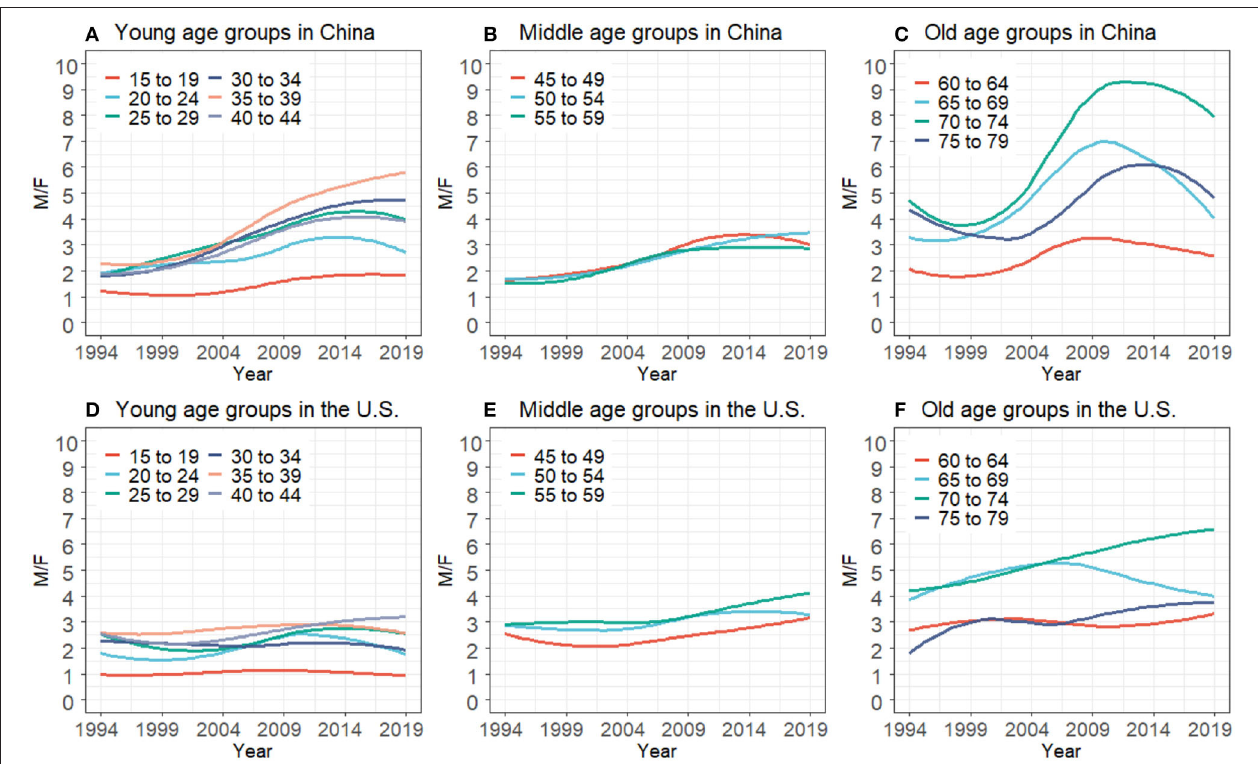
FIGURE 2 | HIV/AIDS men-to-women incidence ratios for the young, middle, and old age groups in China (A–C) and the U.S. (D–F) from 1994 to